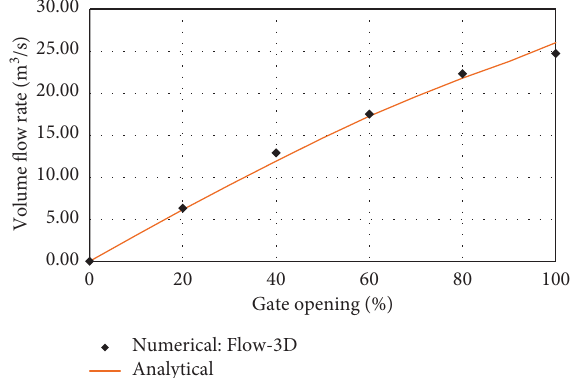
Figure 8: Comparison of analytical solution results and numerical modeling of output flow rate in varying valve openings.